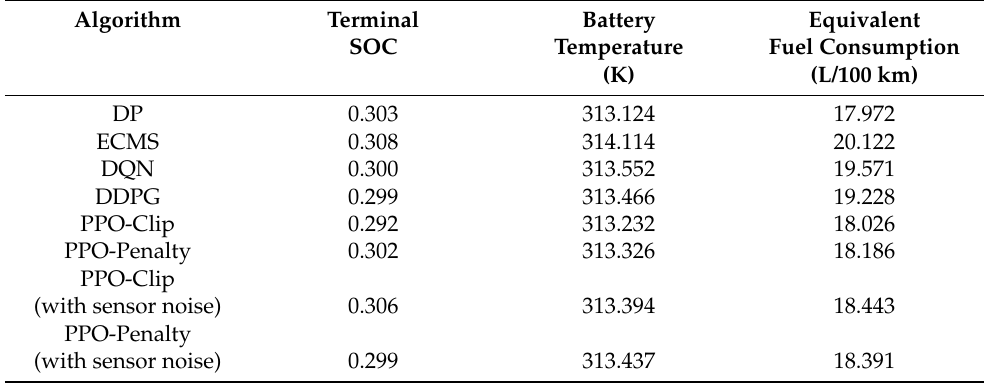
Table 9. The simulation results in a real